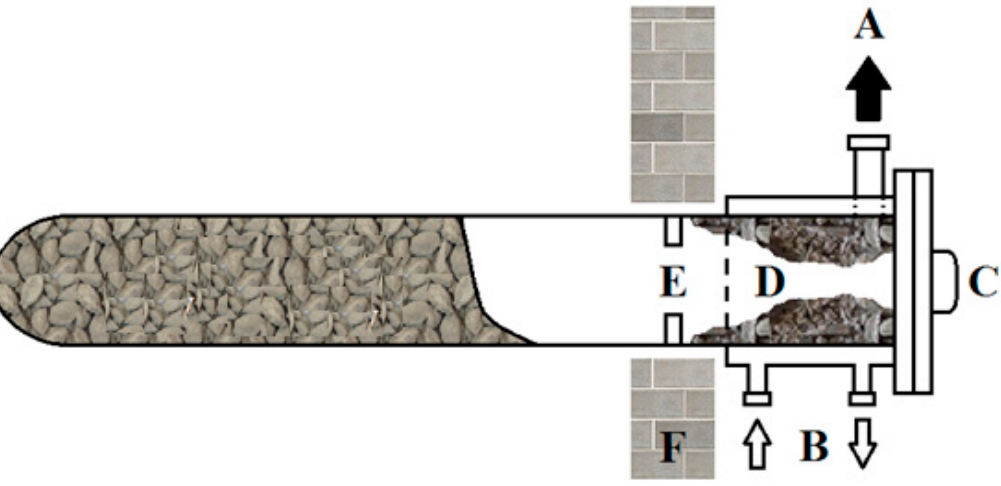
Figure 2. Schematic sketch of experimental setup: ( A ) vacuum pump; ( B ) water inlet-outlet; ( C ) retort cap; ( D ) crown Zn; ( E ) radiation shield; ( F ) furnace wall.